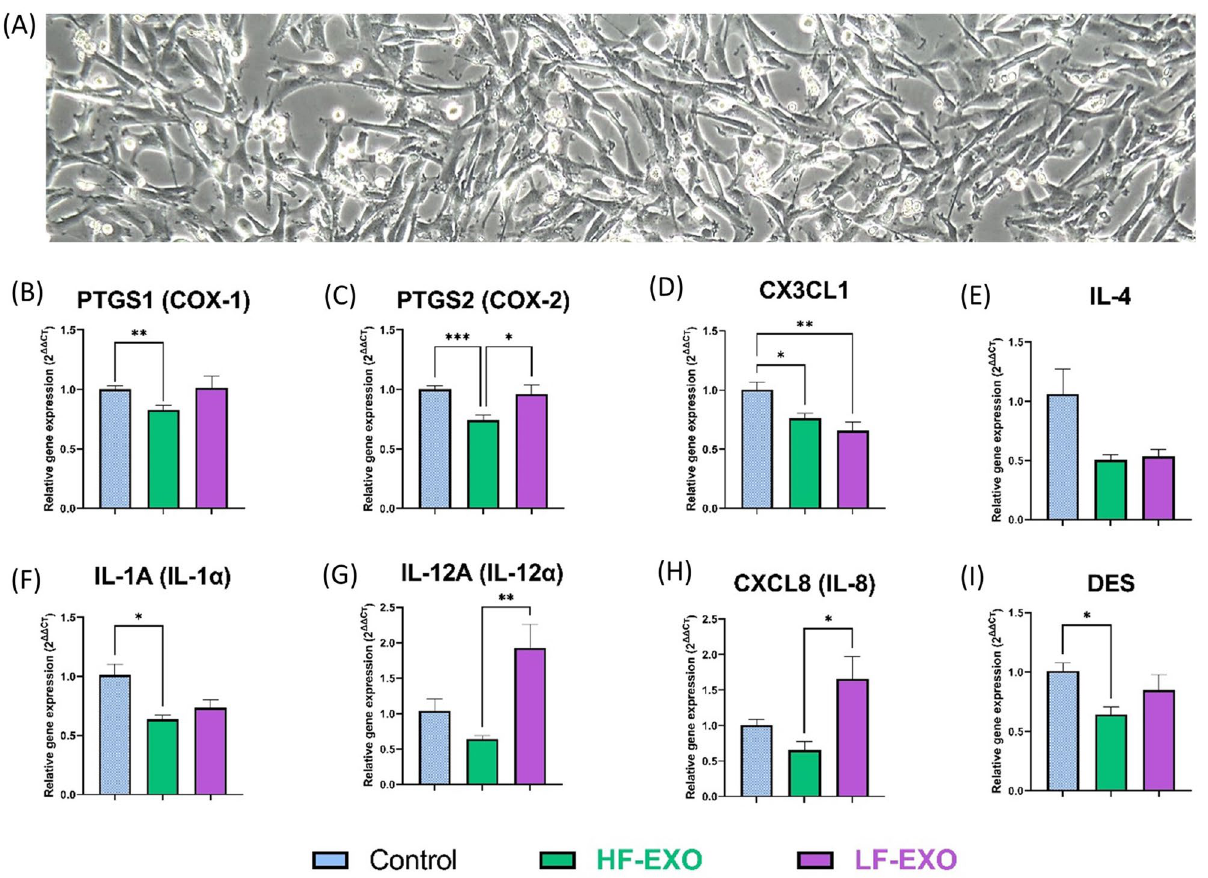
Figure 2. Co-incubation with sEV from dairy cows identified as high fertile (HF-EXO) and low fertile (LF-EXO) lead to differential gene expression in bovine endometrial stromal (bCSC) cells. ( A ) bCSC cells depicts fibroblast-like morphology and grow in multiple layers after confluency (at 48-h, 10X). ( B,C ) Prostaglandin synthase enzyme gene expression, ( D,E ) anti-inflammatory mediator gene expression ( F–I ) pro- inflammatory mediator gene expression in bCSC cells. GAPDH, ACTB and TBP were selected as the house- keeping genes to normalize the qRT-PCR data. Values are presented as mean ± SEM. Brown-Frosythe and Welch ANOVA test along with Dunnett’s T3 multiple comparison was selected as post-hoc test to identify statistical significance differences between the groups. *P ≤ 0.05, **P ≤ 0.01, ***P ≤